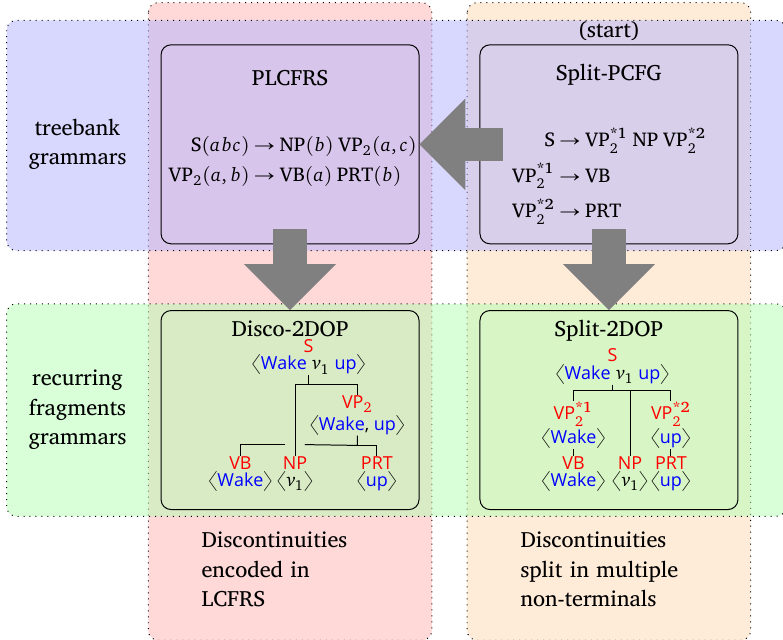
aspects as disambiguation using occurrence frequencies of grammati- cal constructions. Thus, the choice of a formalism to describe the sys- tem’s competence grammar depends on one’s decisions on how syn- tax should be formalized. Regular and context-free grammars have been argued to be too limited (Chomsky 1956; Shieber 1985), while richer alternatives – context-sensitive and beyond – are considered too powerful to allow for an efficient computational implementa- tion; this applies to Transformational Grammar (Peters and Ritchie 1973), Lexical-Functional Grammar, and Head-Driven Phrase Struc- ture Grammar (Trautwein 1995). We may therefore wish to strike a balance and find a grammar formalism that is just powerful enough to describe the syntax of natural language. Joshi (1985) proposes Mildly Context-Sensitive grammars, which are beyond context-free, but avoid the computational complexity that comes with the full class of context- sensitive grammars. The first formalism developed in this framework was Tree-Adjoining Grammar (tag; Joshi 1985). There has